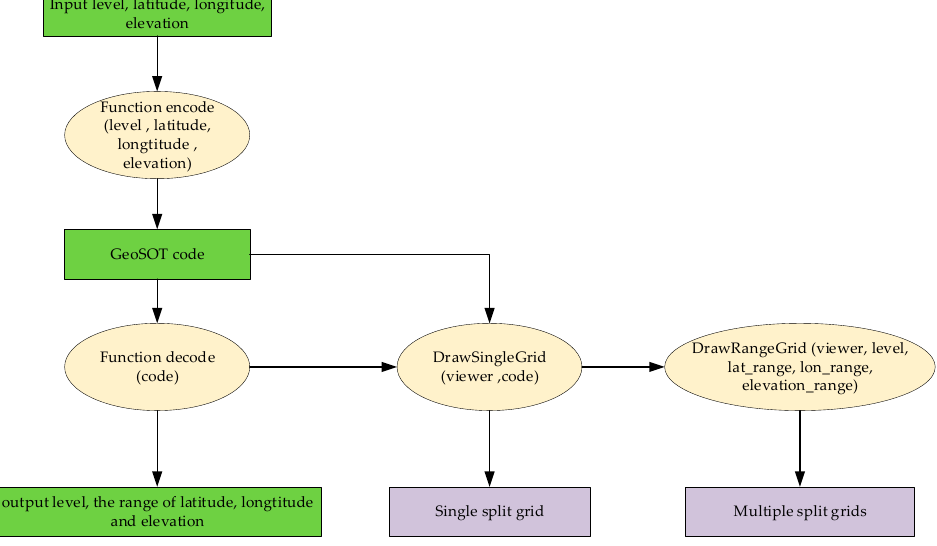
Figure 3. GeoSOT global grid split algorithm flow chart .